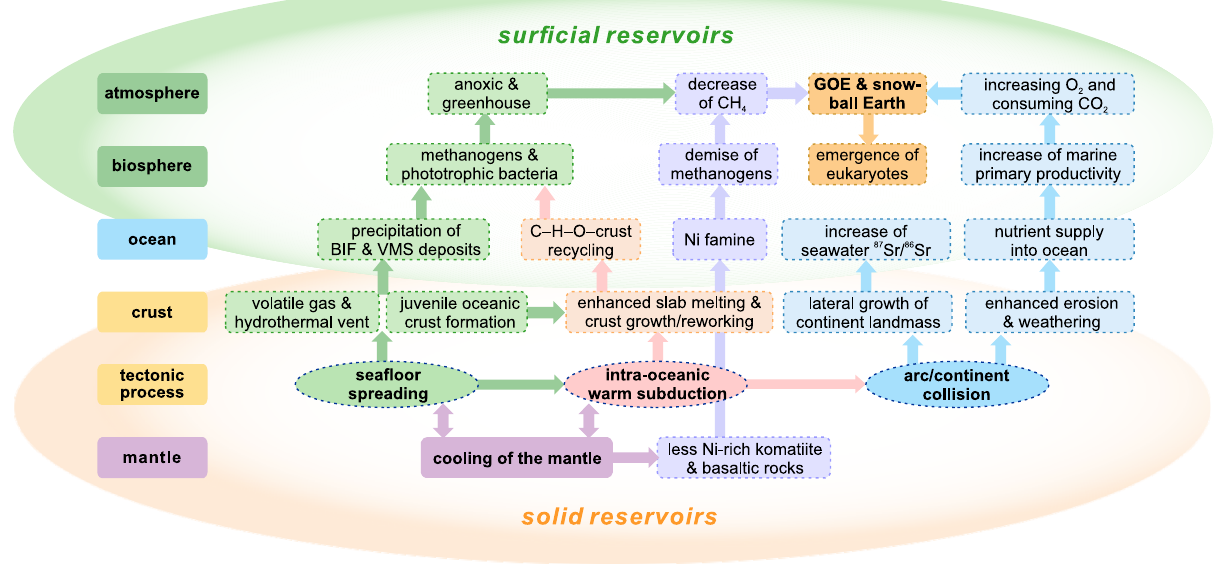
Fig. 9 | Conceptual model for the operation of widespread plate tectonic pro- cesses and its potential in fl uence on sur fi cial environments during the late